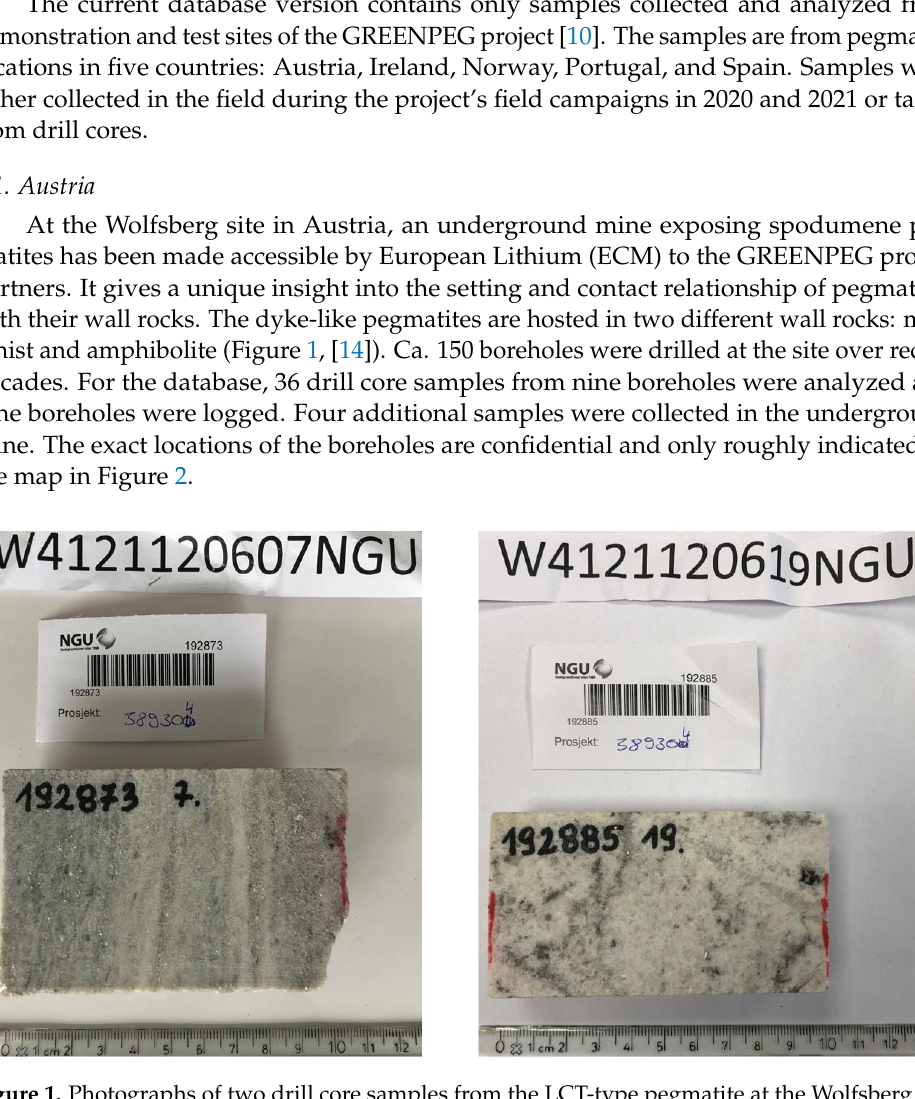
Figure 1. Photographs of two drill core samples from the LCT-type pegmatite at the Wolfsberg site, Austria. Left: Strongly foliated, mica schist-hosted spodumene pegmatite. Right: Non-foliated, amphibolite-hosted spodumene pegmatite.